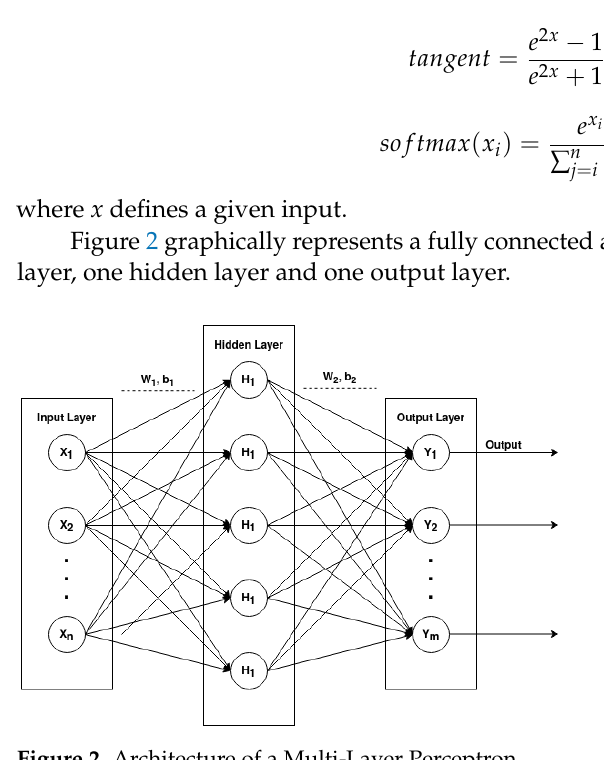
Figure 2. Architecture of a Multi-Layer Perceptron.